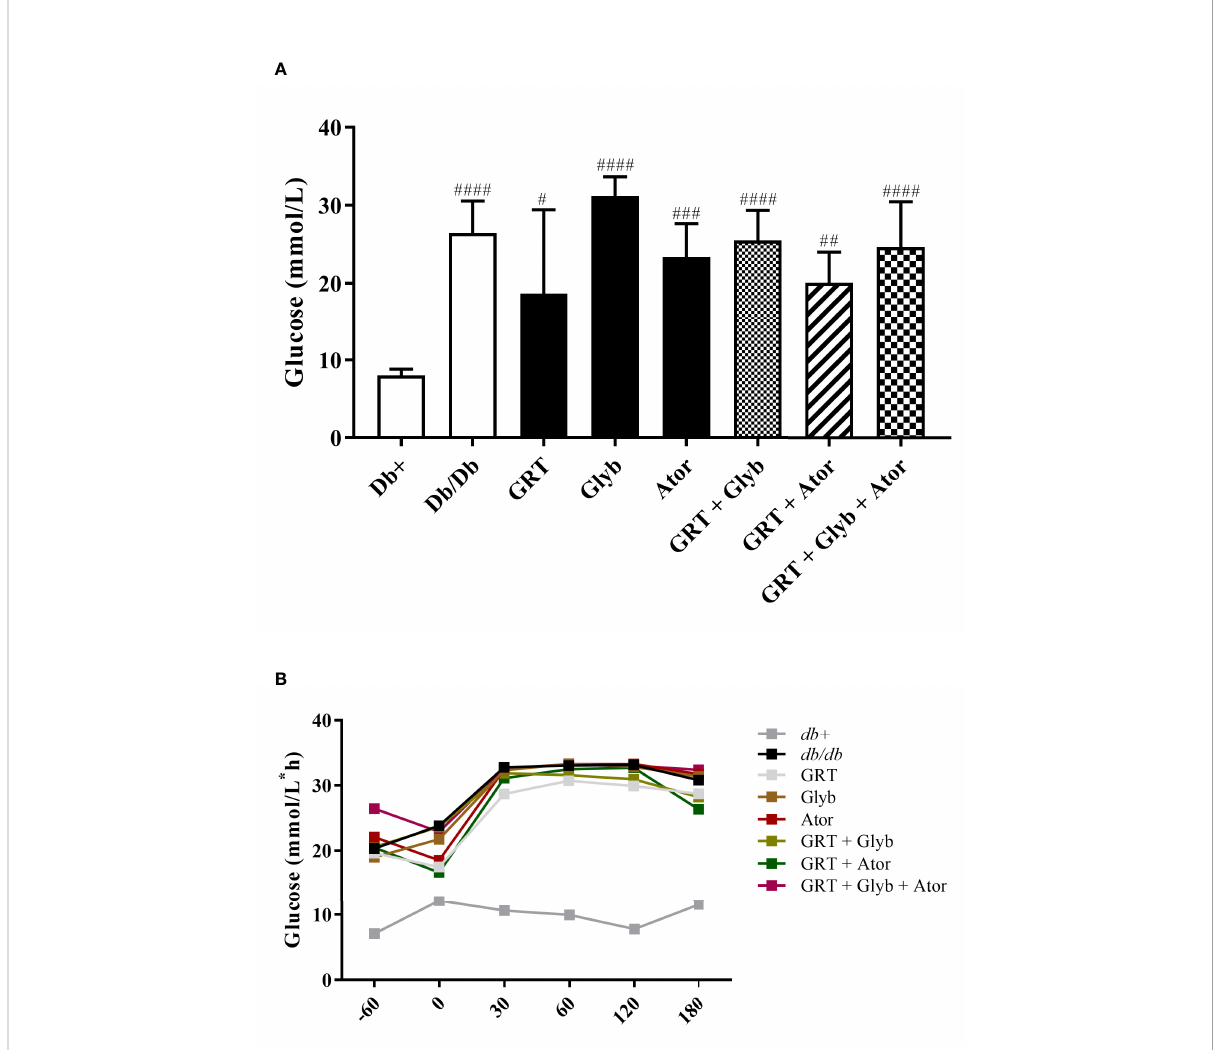
FIGURE 1 The effect of GRT, Glyb and Ator mono - or combination therapy on glycaemia as assessed by (A) fasting plasma glucose (FPG) and (B) intraperitoneal glucose tolerance test (IPGTT). IPGTT and FPG were assessed after 3 and 5 weeks of treatment, respectively. N = 5-6/group. # p < 0.05; ## p < 0.01 and #### p < 0.0001 vs db + (One-Way ANOVA followed by Tukey post-hoc test). GRT, green rooibos extract; Glyb, glyburide; and Ator,